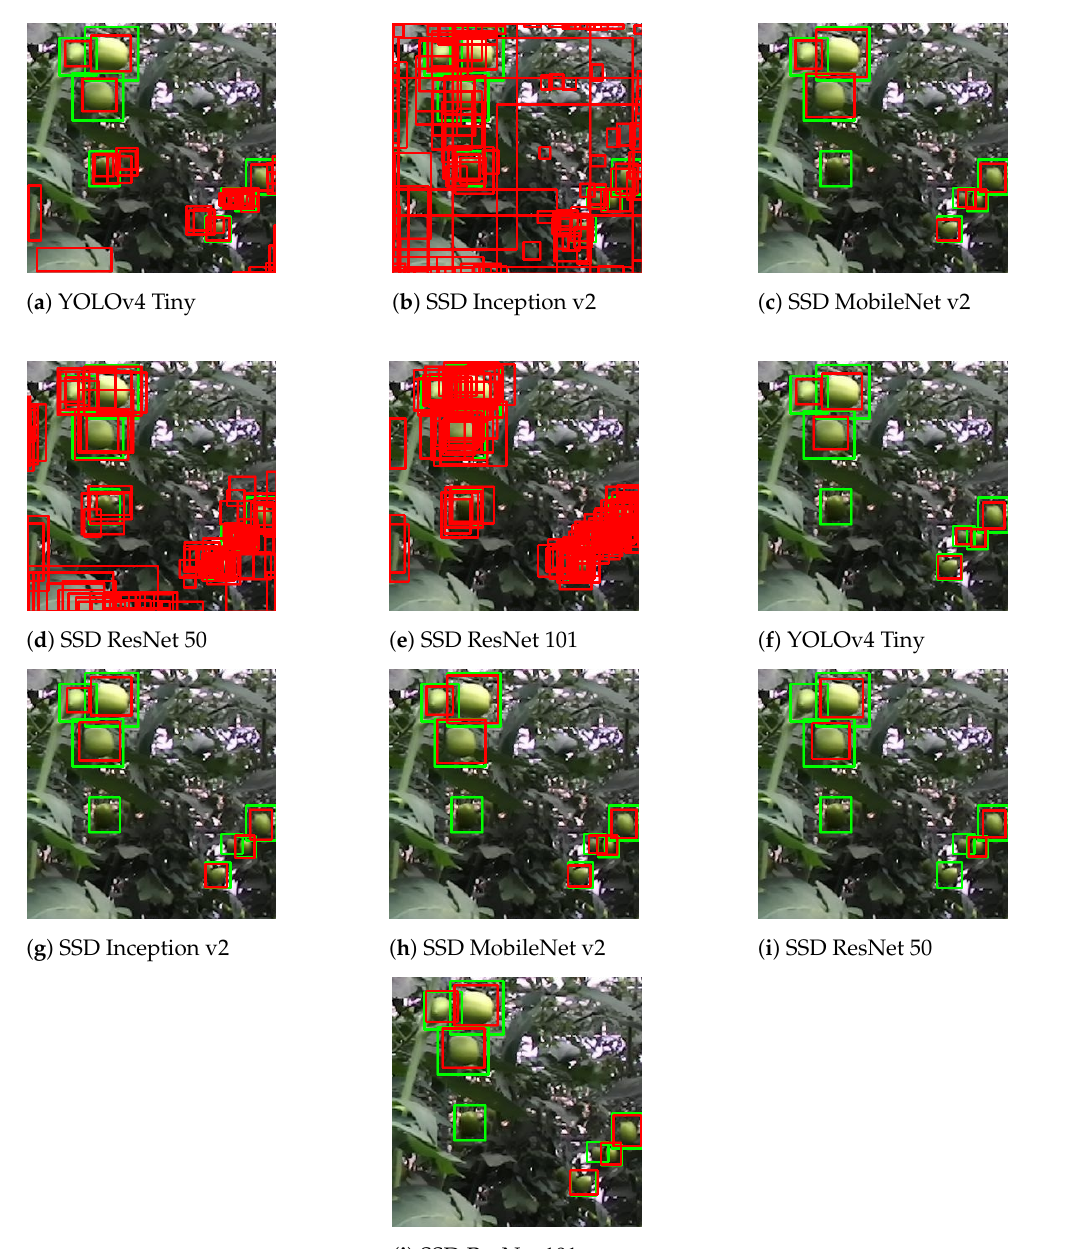
Figure 13. Comparison between using unfiltered images ( a – e ) and filtered images through the computed confidence threshold ( f – j